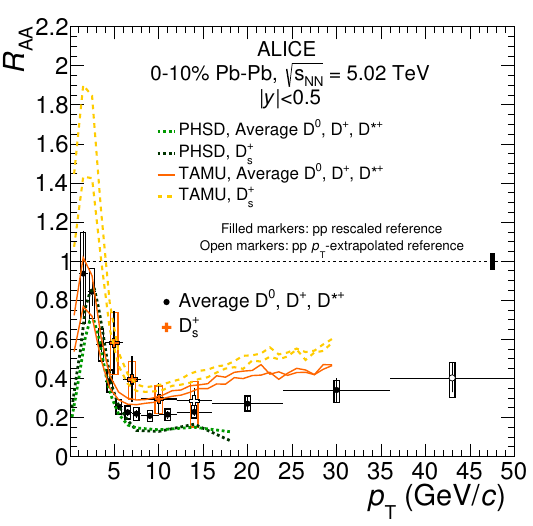
Figure 9 . Average R AA of D 0 , D + and D (cid:3) + mesons and R AA of D + class compared with the PHSD [63] and TAMU [55] model